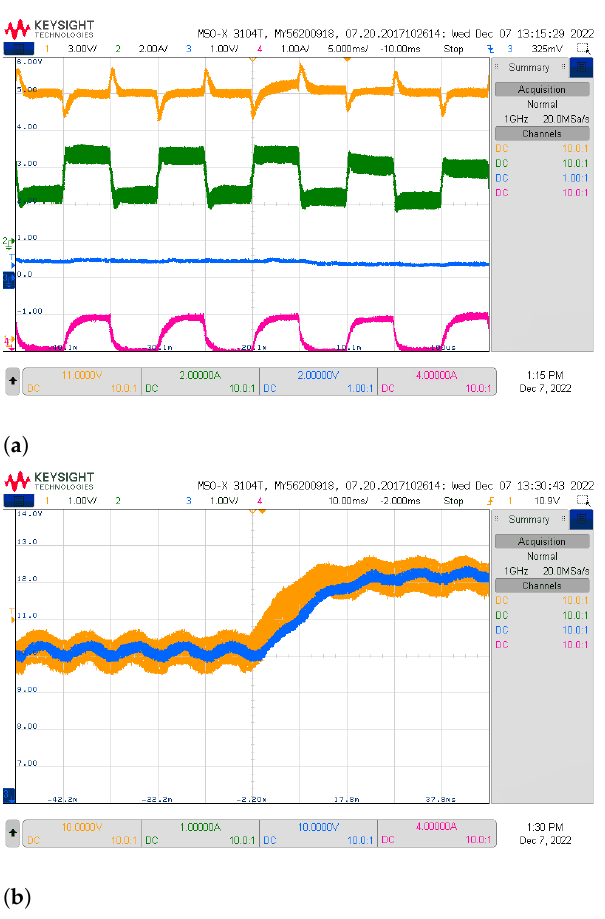
Figure 8. Dynamical response of the proposed controller when the input voltage varies from 10 to 12 V. ( a ) Experimental results for the boost converter when the DC load is a 100 Hz square waveform that varies between 1 and 2 A , with a duty cycle of 0.5. CH1: x 2 (3 V/div), CH2: x 1 (2 A/div), CH3: u (1/div), CH4: ˆ i DC (1 A/div), and time base of 5ms. ( b ) Input voltage changes from 10 V to 12 V. CH1: (1 V/div), CH3: (1 V/div), and time base of